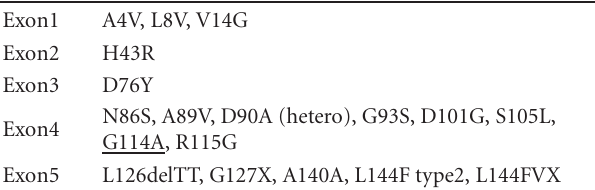
Underlined mutation could not detect the mutation by HRM